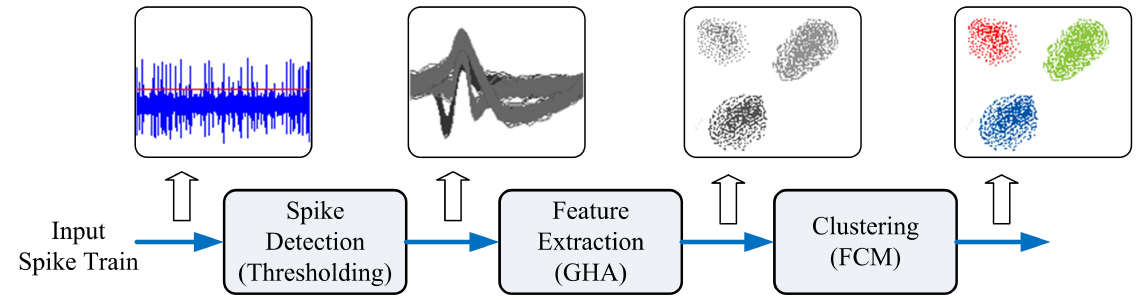
Figure 12. The operations of the SOC-based spike sorting